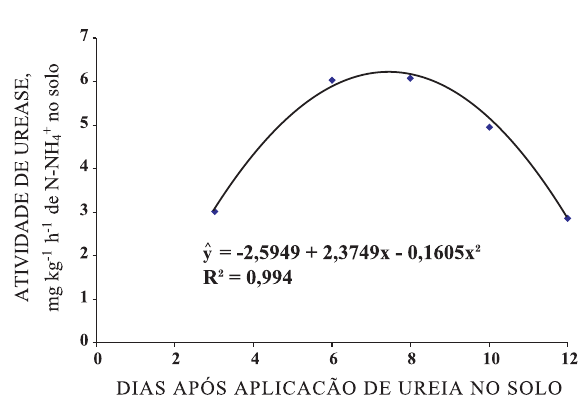
Figura 3. Atividade de urease na camada de 0–10 cm de solo no estádio de floração da cultivar de feijoeiro BRS Valente em função do número de dias após a aplicação de ureia. Valores médios de quatro plantas de cobertura e dois preparos de